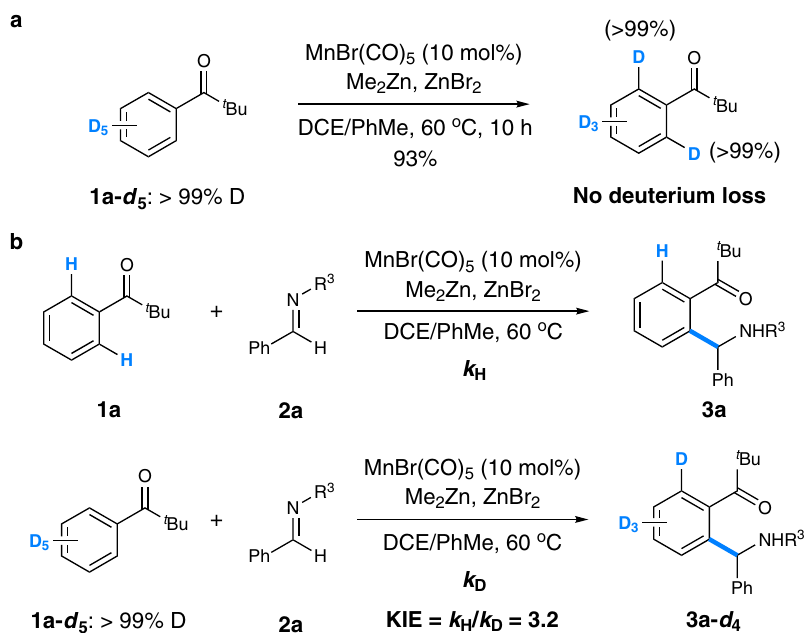
Fig. 9 Deuterium-labeling experiments. a Probing the reversibility of the C – H bond cleavage. b Probing the kinetic isotope effect. DCE 1,2-dichloroethane